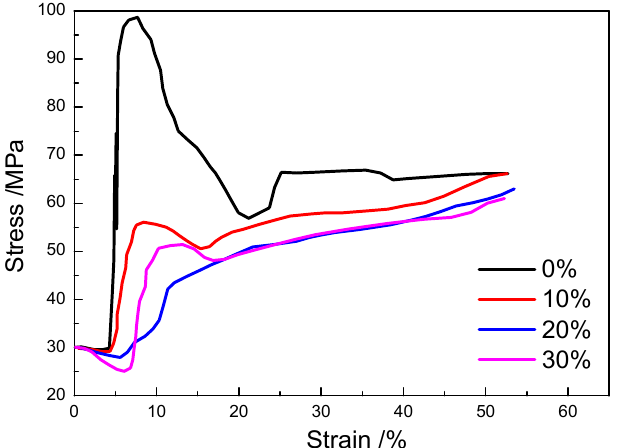
Figure 17. Casing stress transferred by cement sheath added with different high-strength hollow bead proportions.